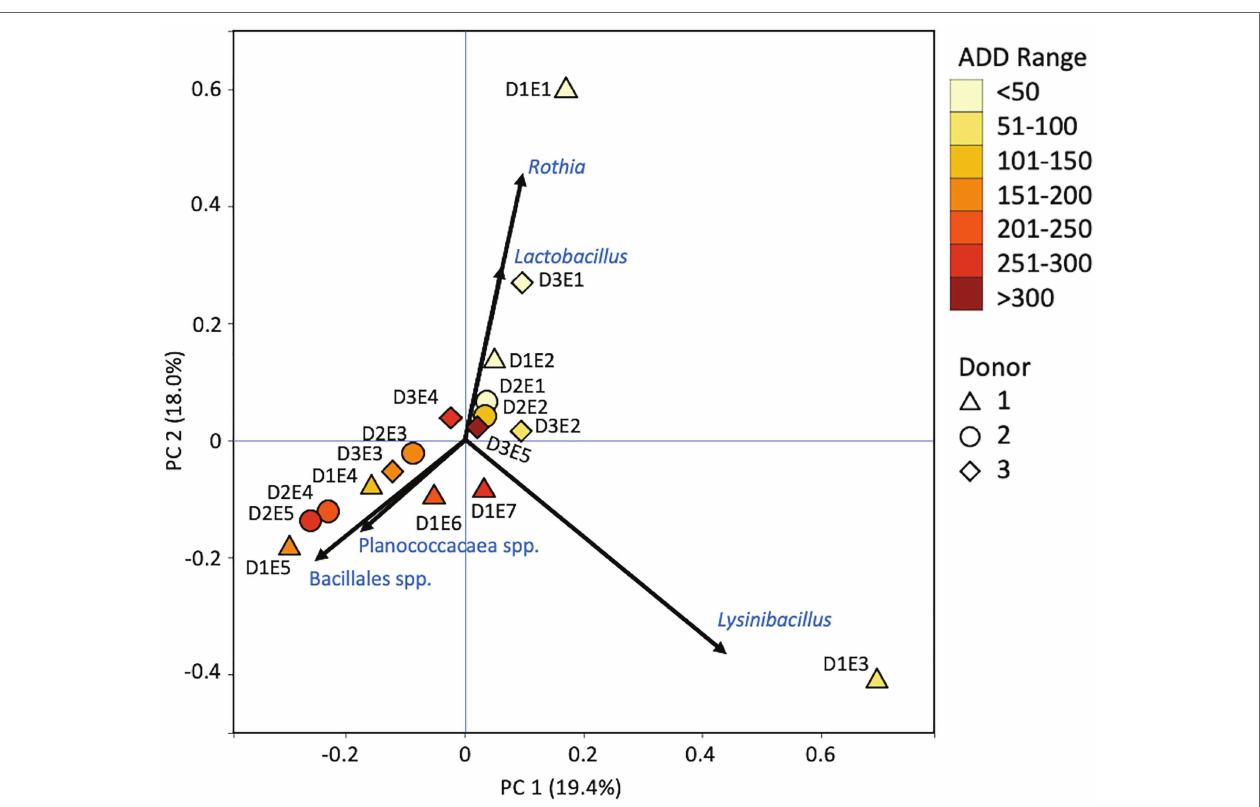
FIGURE 5 | Principal components analysis plot for the proportional data of bacterial genera observed from 16S rRNA gene sequencing of the V6–V8 hypervariable region from oral samples of three human donors (Donors 1, 2, and 3) during decomposition. Shading is added to the symbols [triangles for Donor 1 (D1), circles for Donor 2 (D2), and diamonds for Donor 3 (D3)] to show earlier (lighter shading) to later (darker shading) ADD and also times sampled (from E1 to E7 for D1 and E1 to E5 for D2 and D3, indicating first sample to last sample